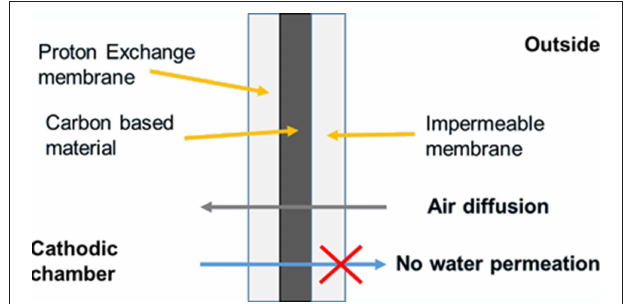
FIGURE 3 | Air cathode configuration.